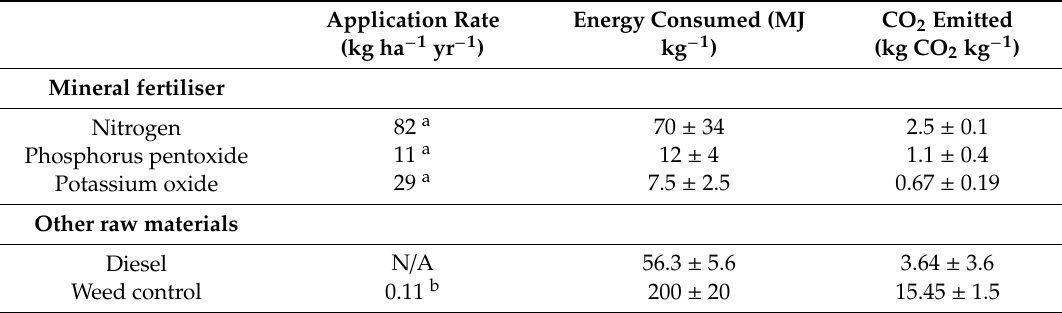
Table 3. Energy consumed and CO 2 emitted from raw materials. Reproduced from [36], Elsevier: